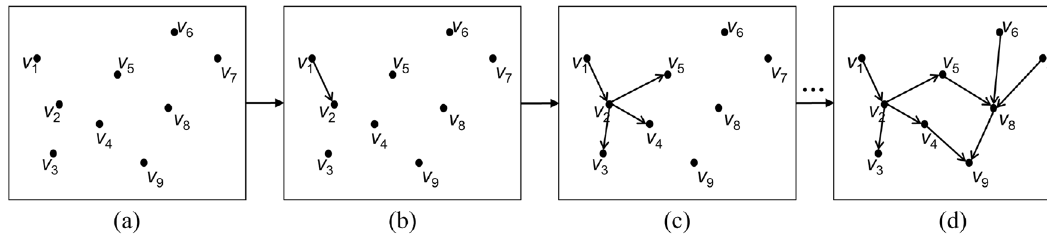
Fig. 8 The process of constructing a trip graph